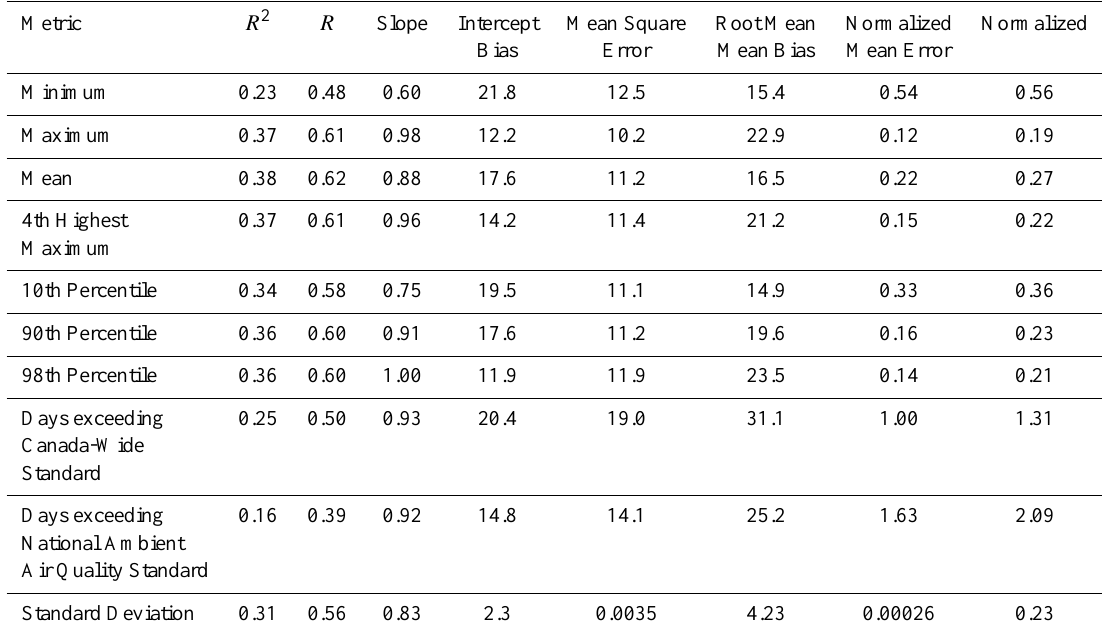
Table 3. AURAMS-CRCM Performance Statistics for “Current” scenario: ozone. Metric R 2 R Slope Intercept Mean Square Root Mean Normalized Normalized Bias Error Mean Bias Mean Error Minimum 0.23 0.48